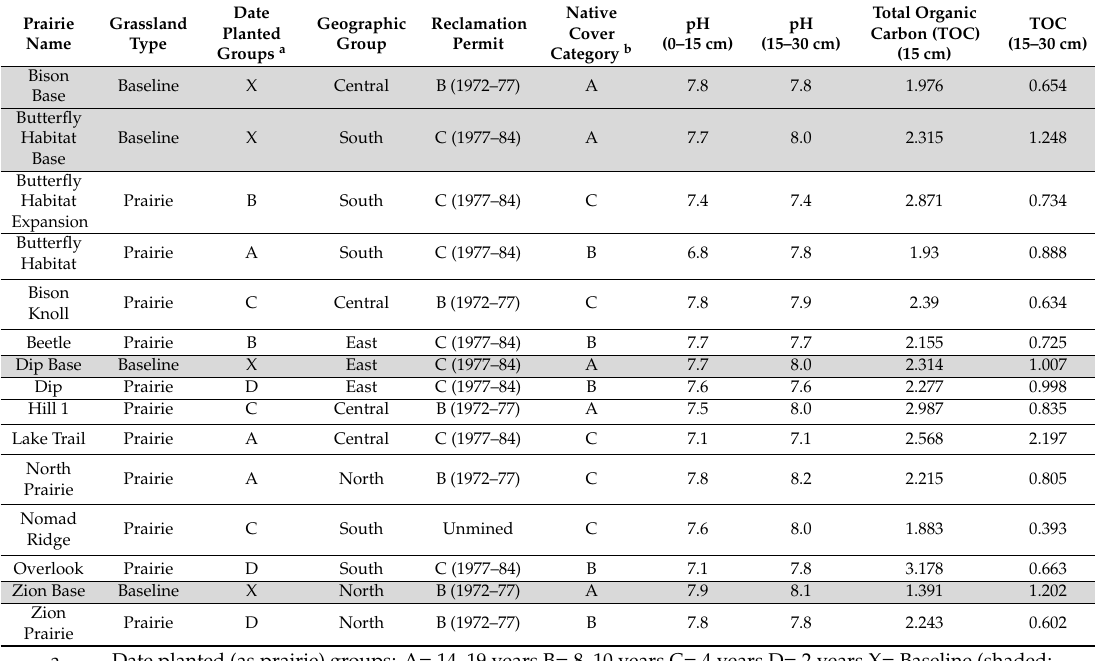
Table 1. Characteristics, vegetation cover, and soil parameters (in 2017) for grassland study areas. Prairie